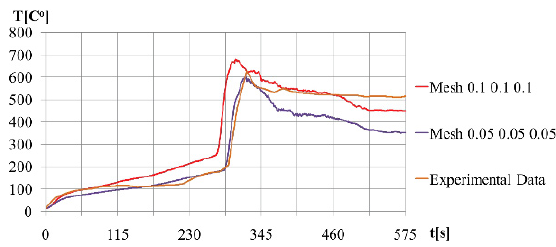
Figure 13. Average hot gases temperatures of numerical simulation for 5.1 m/s wind velocity, direction East and data from fire experiment in